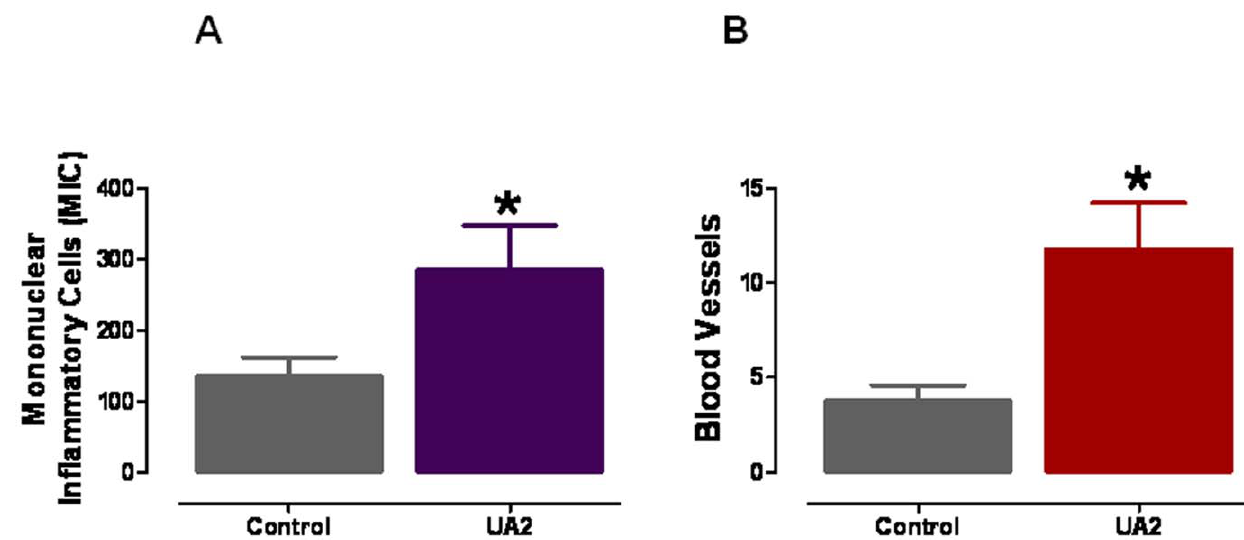
Figure 5. Wounds treated with a uric acid analog exhibit enhanced infiltration of immune cells and enhanced growth of blood vessels. A. Numbers of mononuclear immune cells in wound tissue 5 days after the injury in control and UA2-treated mice. B. Numbers of blood vessels in wound tissue 5 days after the injury in control and UA2-treated mice. Values are the mean and SEM (n=6 mice). *p , 0.05.